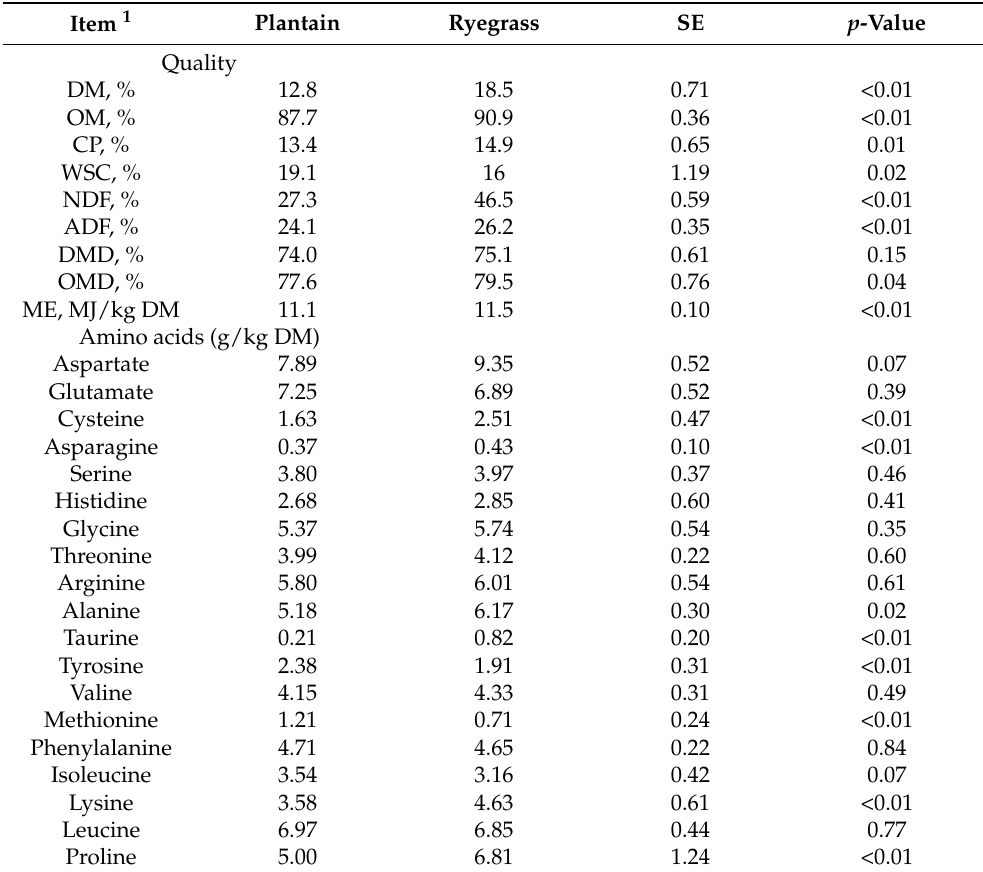
Table 1. Herbage chemical characteristics and amino acid content of feed provided to cows considered divergent for milk urea nitrogen breeding values (MUNBV) consuming a diet of either plantain or ryegrass. Item